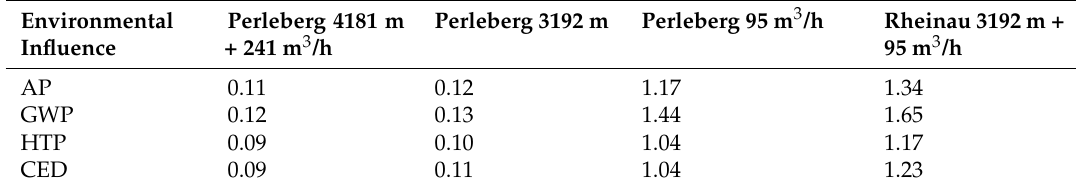
Table 7. Error in % for calculated LCA results with formula